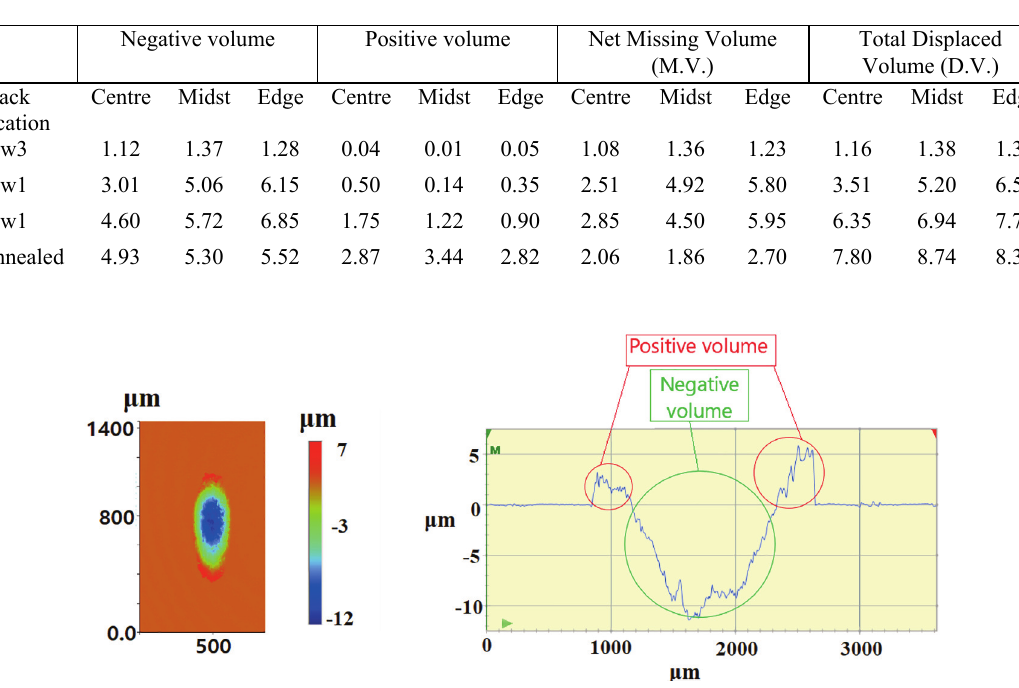
Fig. 6. Results of confocal microscopy analysis on the v1w1 specimen in the centre zone [14]. Left: 3D-profile analysis of the wear track. Right: cross-section of the wear track. The built-up edge was considered as the positive displaced volume, and the groove space as the negative